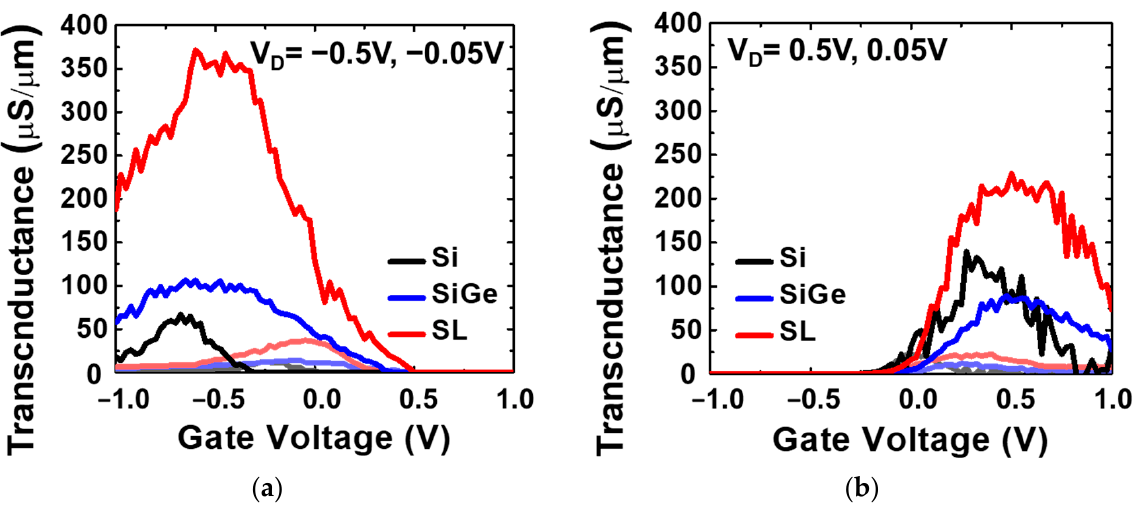
Figure 10. G m characteristics of ( a ) P-type Si 0.8 Ge 0.2 /Si SL, Si 0.8 Ge 0.2 , and Si FinFET and ( b ) N-type Si 0.8 Ge 0.2 /Si SL, Si 0.8 Ge 0.2 , and Si FinFET with L G = 200 nm and F W = 30 nm. Figure 11a displays the I D -V G characteristics of the CMOS inverter operation using the Si 0.8 Ge 0.2 /Si SL FinFETs, with F W = 35 nm and L G = 125 nm for the P-type and F W = 30 nm and L G = 200 nm for the N-type. The Si 0.8 Ge 0.2 /Si SL FinFET CMOS inverter exhibits SS avg,P = 87.6 mV/dec, SS avg,N = 96.4 mV/dec, the drain-induced barrier lowering (DIBL) values of DIBL P = 15.6 mV/V, DIBL N = 49.9 mV/V, and high I ON /I OFF greater than 10 6 at V D = ± 0.5V. In Figure 11b, the drive current (V OV = V D = ± 0.7 V) of the Si 0.8 Ge 0.2 /Si SL FinFET CMOS inverter is 245.9 µ A/ µ m and 176.8 µ A/ µ m for the P- and N-type Si 0.8 Ge 0.2 /Si SL FinFET, respectively. Figure 11c depicts the voltage transfer characteristic (VTC) of the Si 0.8 Ge 0.2 /Si SL FinFET CMOS inverter, with a maximum gain of 91 v / v by varying the supply voltage from 0.6 V to 1.2 V, as shown in Figure 11d.